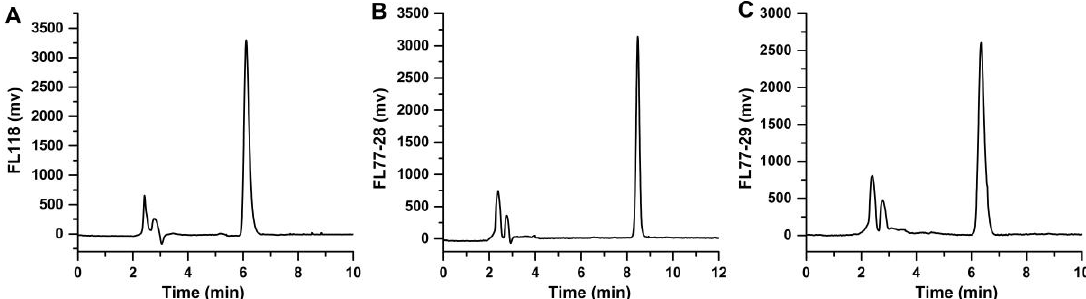
Figure 1. Representative chromatograph, FL118 with a retention time of 6.109 min ( A ), FL77-28 with a retention time of 8.456 min ( B ), and FL77-29 with a retention time of 6.351 min ( C ).